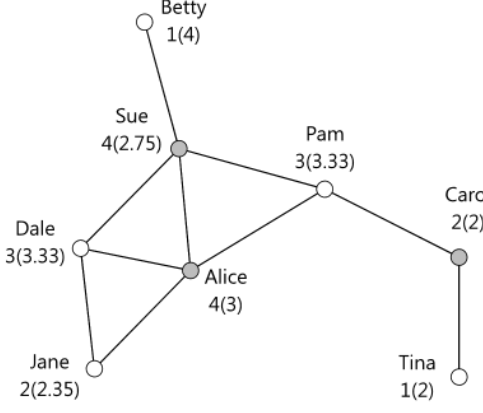
Figure 1: Friendships among eight girls in “Marketville” high